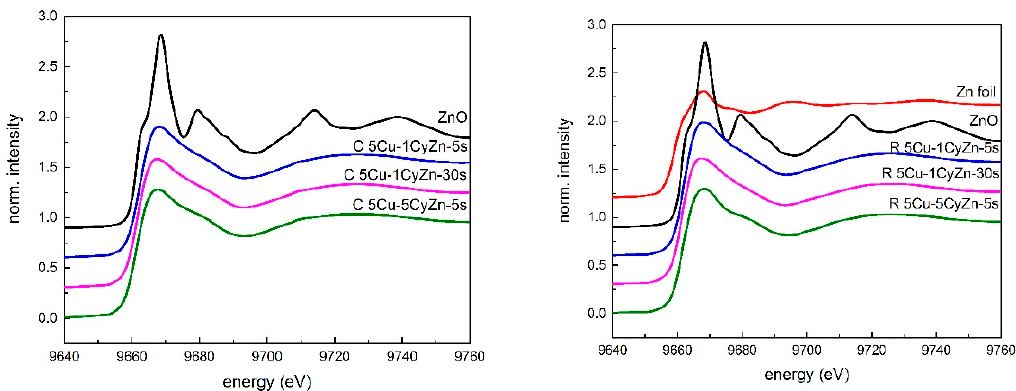
Figure 10. Experimental XANES spectra registered Zn K-edge of calcined ( left ) reduced ( right ) SEA-5Cu and ZnO over-coated Cu/SiO 2 catalysts ( left ).